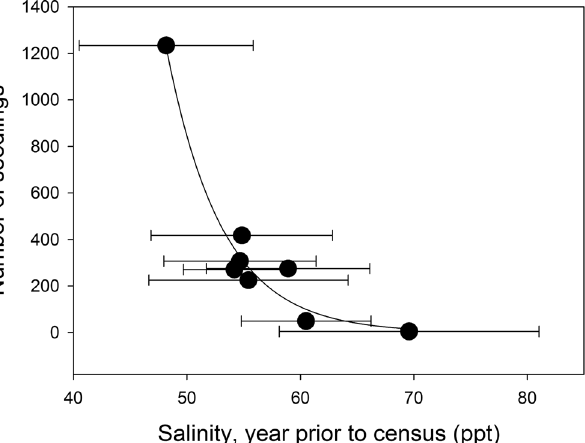
Figure 6. The relationship between the total number of seedlings observed in the monitoring plots and the mean soil porewater salinity ( ± standard deviation) for the year prior to the seedling survey (when propagules were developing). Seedlings were surveyed in 12, 5 × 5 m plots (total area of 300 m 2 ). Curve is an exponential decay of the form y = 22,149,609 ( ± 22,954,957) * exp ( − 0.2035 ( ± 0.0208) * x), R 2 = 0.96, where standard error of the parameter estimates is in